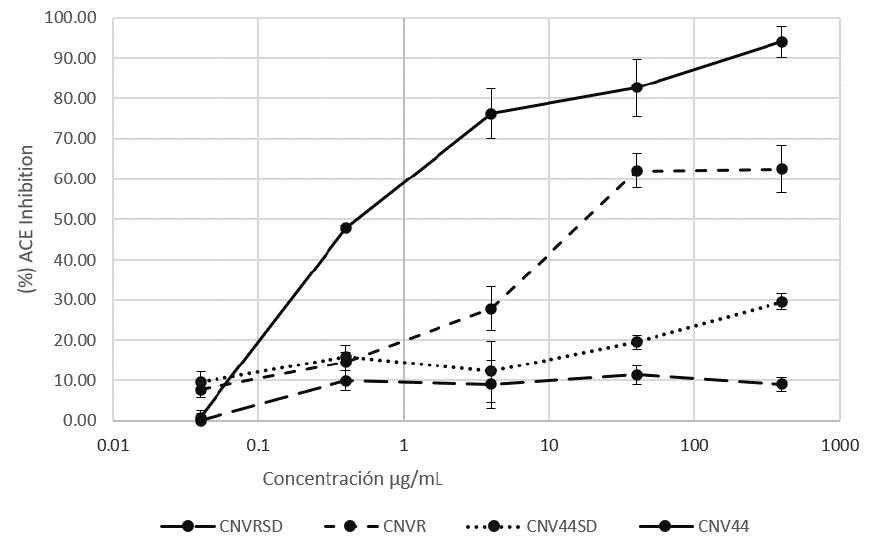
Figure 7. ACEI activity of CNVR and CNV44 and their hydrolysates.